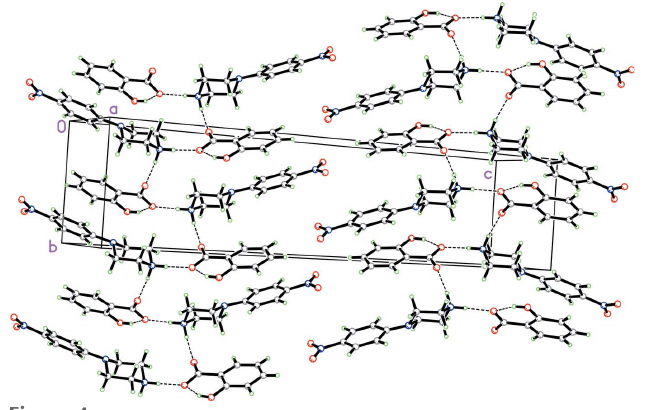
Figure 4 Packing diagram for 1 showing the zigzag chain of hydrogen bonds [graph-set notation C 2 (6)] propagating in the a -axis 2